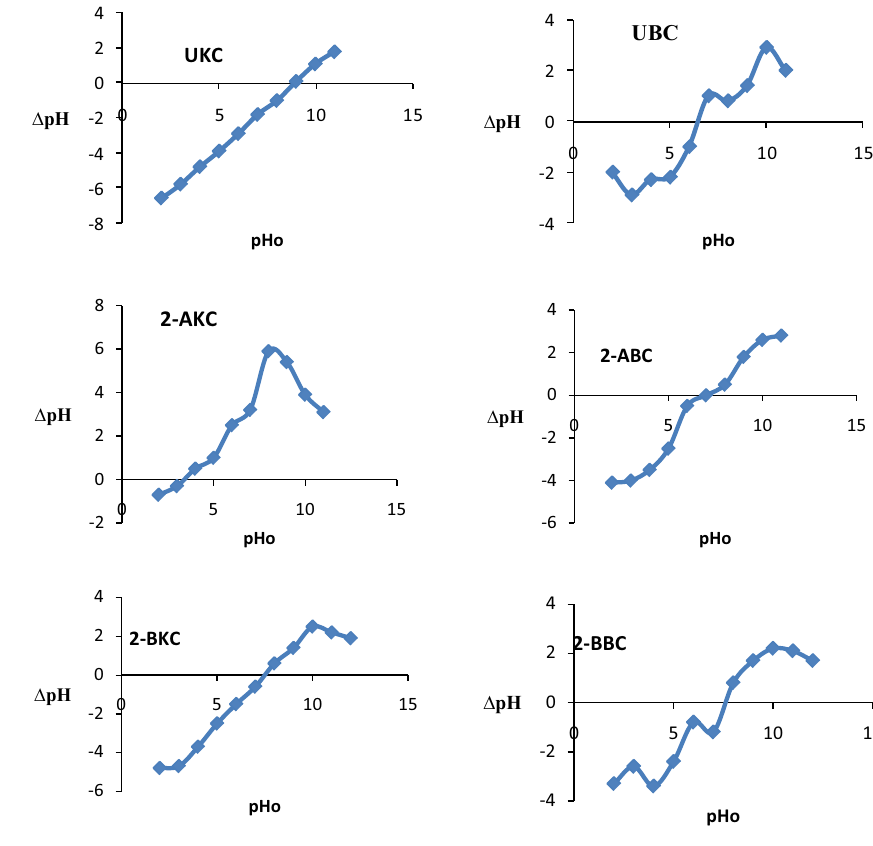
Fig. 1 Plot of pHpzc of UKC, UBC, 2-AKC, 2-ABC, 2-BKC and 2-BBC